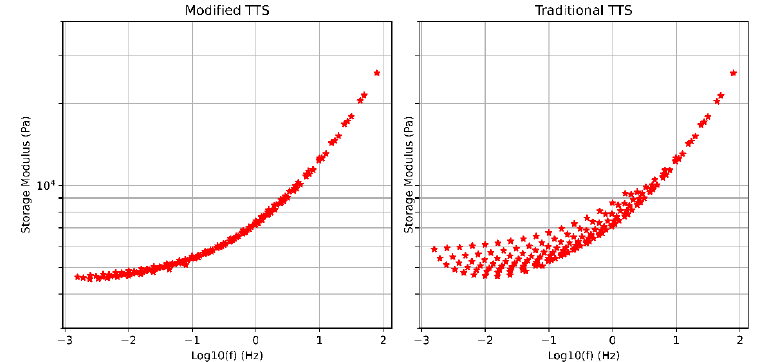
Fig. 4. TTS Mastercurve for Sylgard184 with 20% of recommended crosslinker at 20 o C. Left, modified TTS. Right, ‘traditional’ TTS. Note the poor performance of traditional TTS shifting